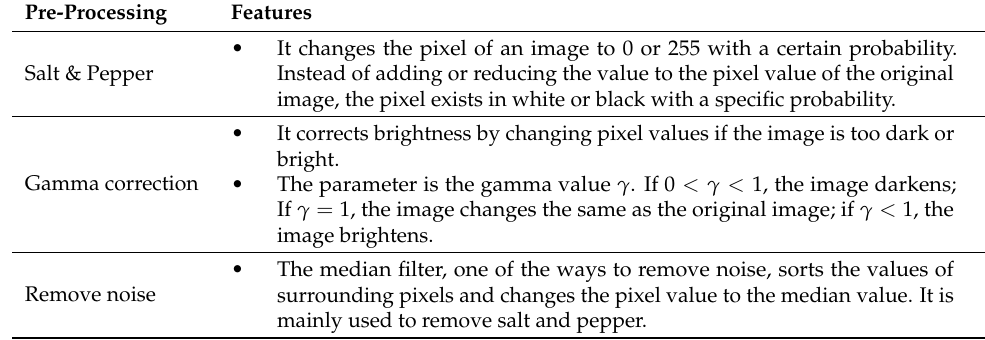
Table 3. Pre-processing methods.